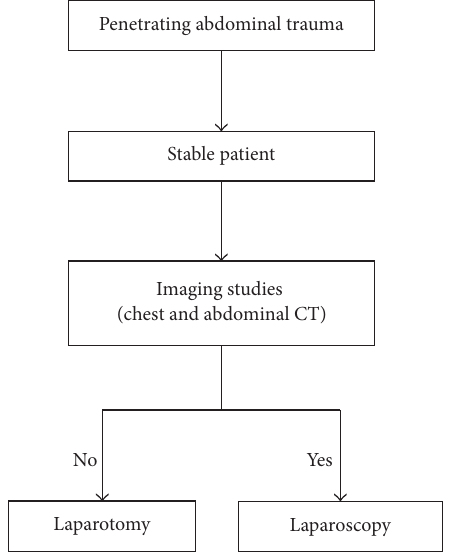
Figure 5: Treatment algorithm. Major criteria were stable patient and no signs of injuries in abdominal